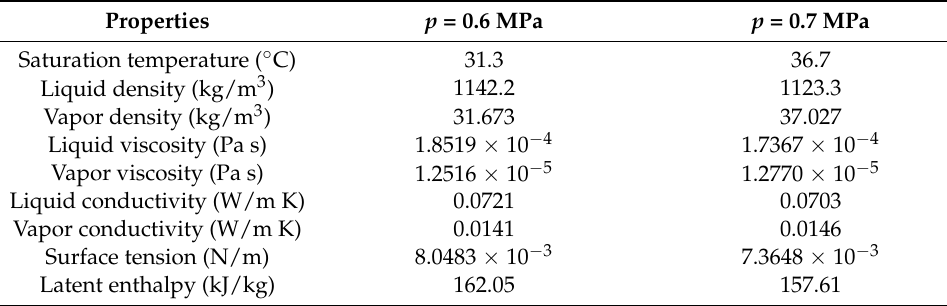
Figure 4. Test section: ( a ) photograph; ( b ) cross profile. Table 1. Thermophysical properties of